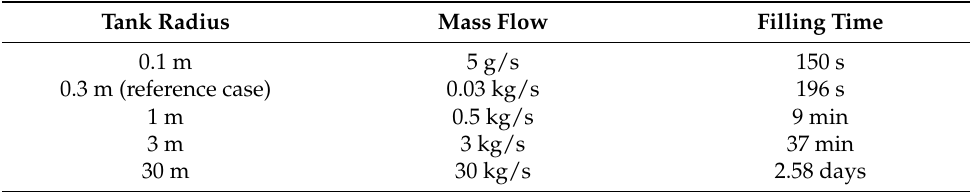
Table 6. Tank sizes and corresponding mass flows and filling times.